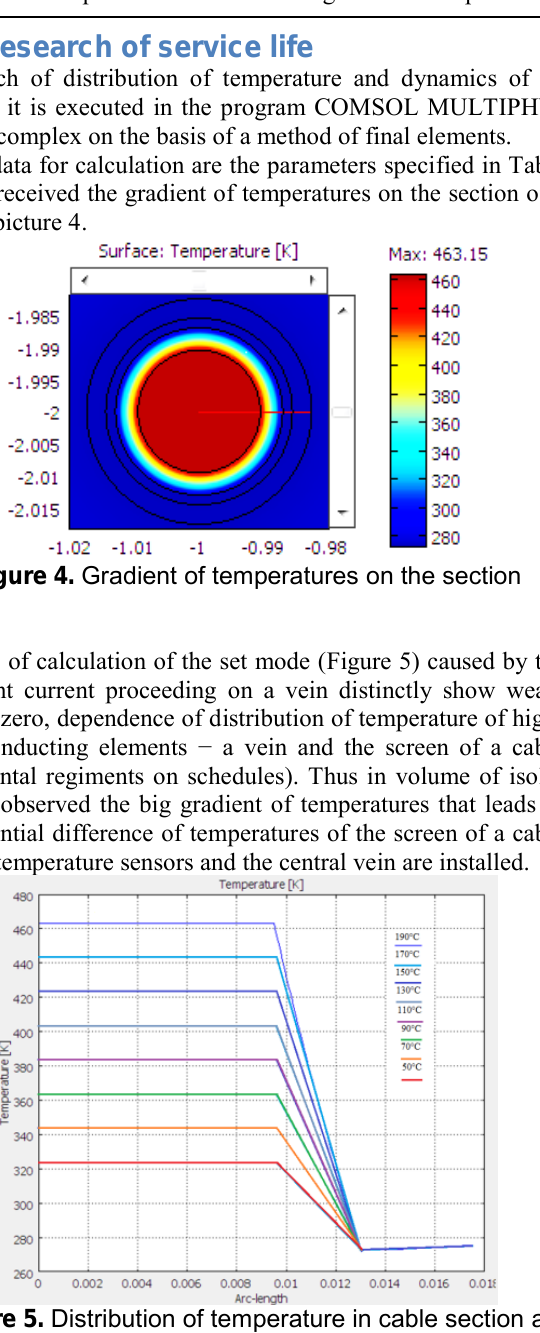
can significantly differ.